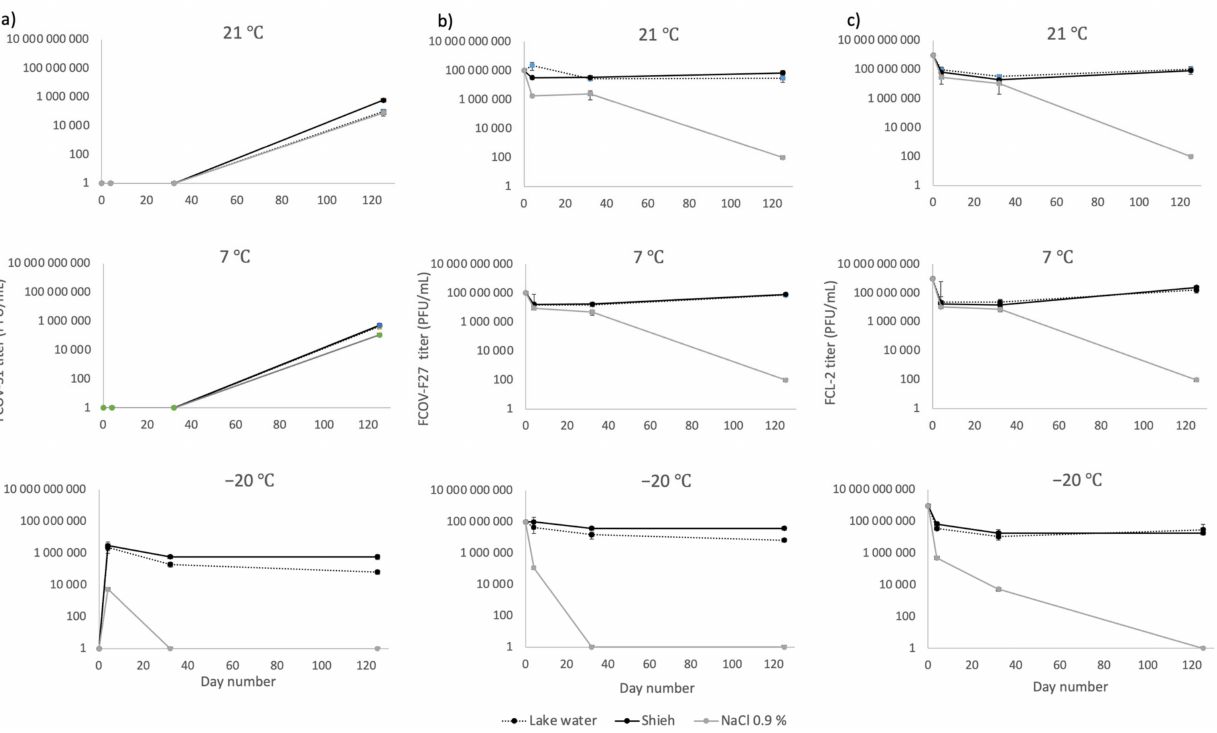
Figure 5. Shelf-life, determined as mean plaque forming units (PFU) mL − 1 , of Flavobacterium columnare phages ( a ) FCOV- S1, ( b ) FCOV-F27, and ( c ) FCL-2 at different storage temperatures and in different media. Error bars indicate standard error of mean. Number of replicate measurements was 3 for lake water and 2 for Shieh medium and NaCl